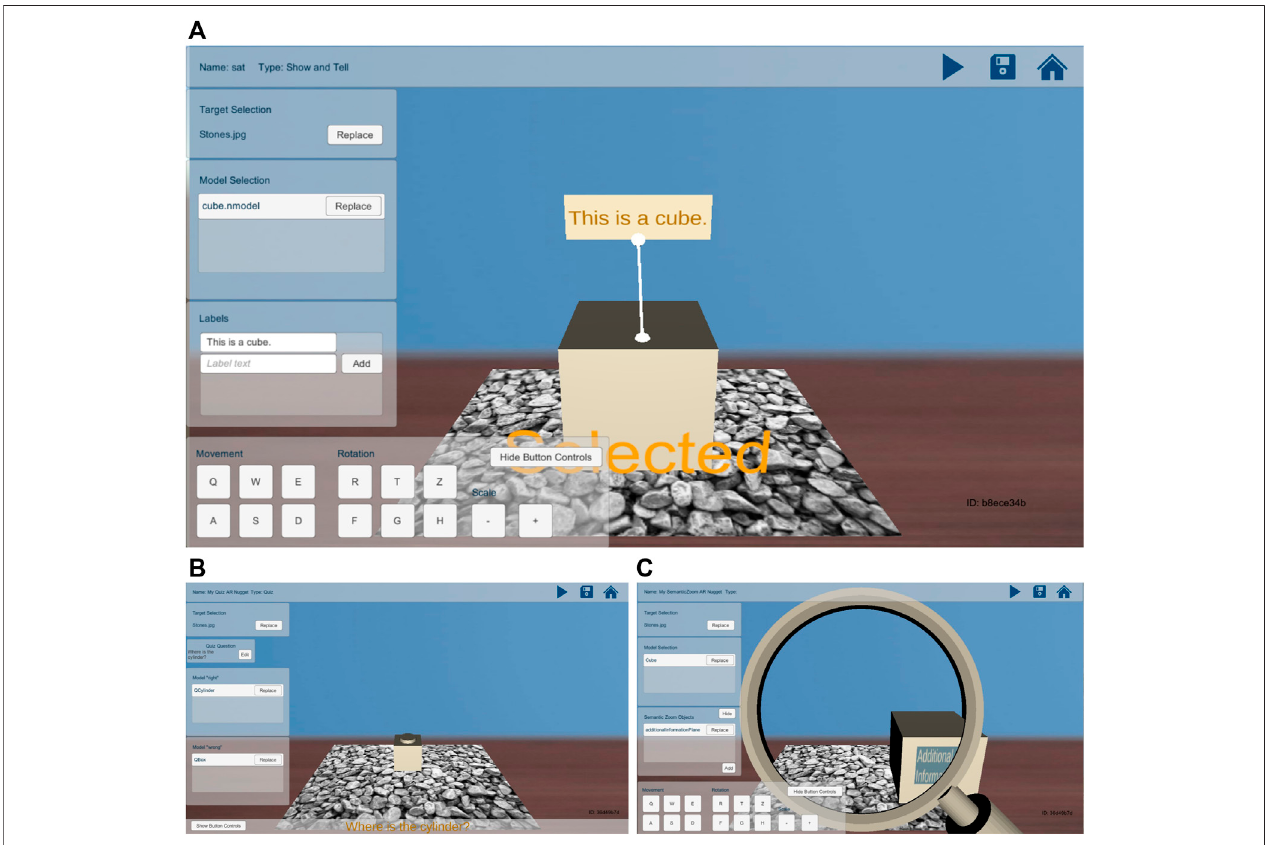
FIGURE 3 | Screenshots from the AR Nugget authoring tool on the desktop device. (A) : A default show & tell AR nugget with the default cube selected. (B) : A default quiz AR nugget. (C) : A default semantic zoom AR nugget.